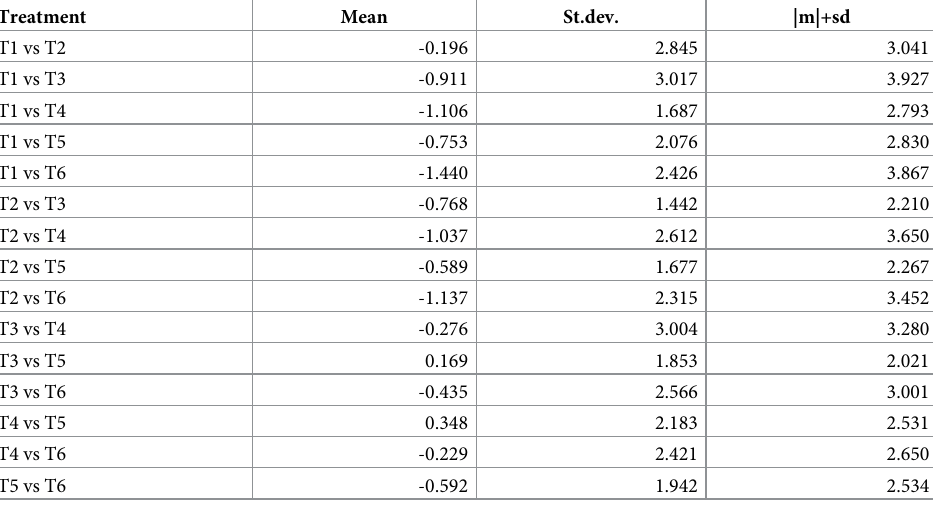
Table 5. Analysis of the relative humidity measured in each treatment. Data are expressed in percentage. Treatment